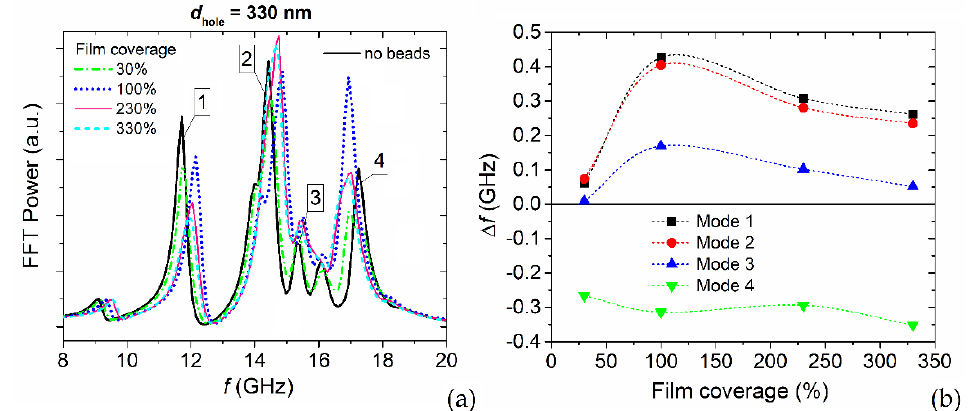
Figure 7. ( a ) FFT power spectra of the average magnetization component along the excitation field direction ( x -axis) for a bias field of 150 kA/m parallel to the y -axis. The graph shows the FMR responses of the permalloy nanostructured film with 330 nm holes to the stray field generated by MagSIGNAL-STa beads, as a function of film coverage. ( b ) Corresponding FMR frequency shifts for the edge (#1), first extended (#2), second extended (#3), and localized (#4) modes, versus film coverage percentage.